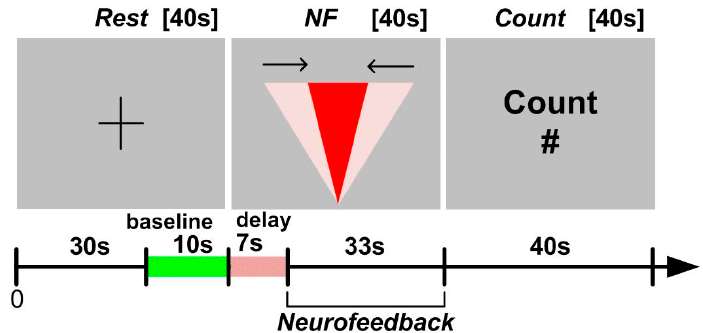
Figure 4. The neurofeedback (NF) protocol used for the 8-puzzle experiment. Note that the last 10s of a resting epoch are used to determine the prefrontal cortex (PFC) asymmetry baseline a priori to the NF epoch. The 7-s delay is introduced to take into account the onset of haemodynamic response in fNIRS. The NF epoch is followed by a non-motivational cognitive task facilitating the return to a new baseline [71].